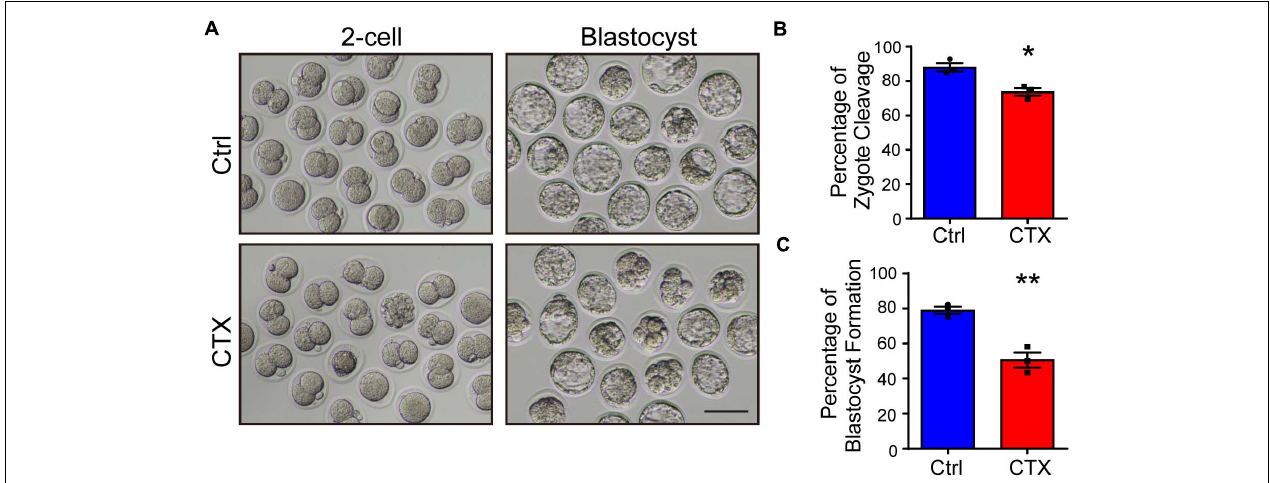
FIGURE 3 | Detrimental effects of CTX on embryo developmental competence. (A) Representative images of the developmental stage of 2-cell and blastocyst formation after in vitro fertilization of oocytes with or without CTX exposure. (B,C) The percentage of IVF embryo development rates between the two groups. Scale bar = 100 µ m. Data was expressed as mean ± SEM. * P < 0.05, ** P < 0.01.